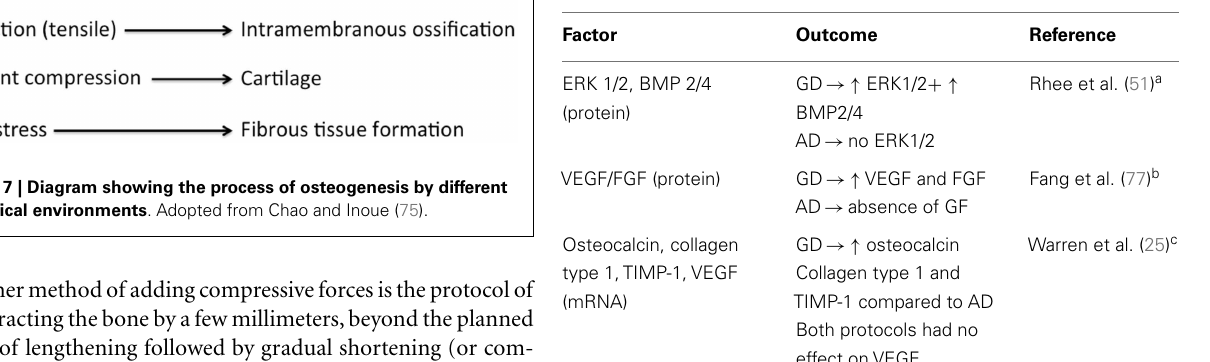
Table 2 | Factor expression in acute versus gradual distraction osteogenesis in rat mandibles